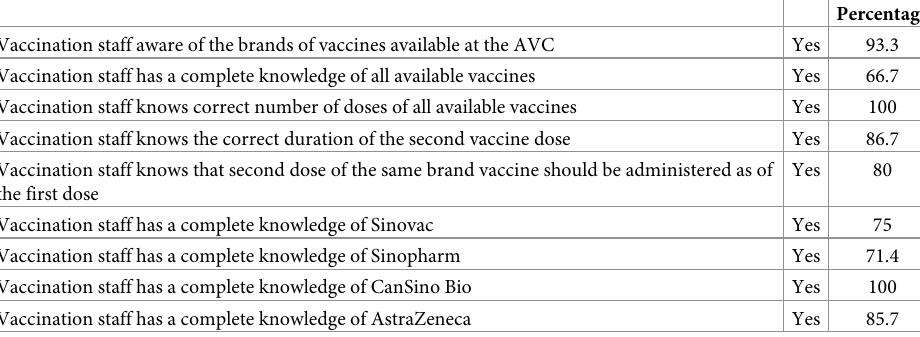
Table 2. Knowledge of the vaccination staff on available COVID-19 vaccines at the AVCs.